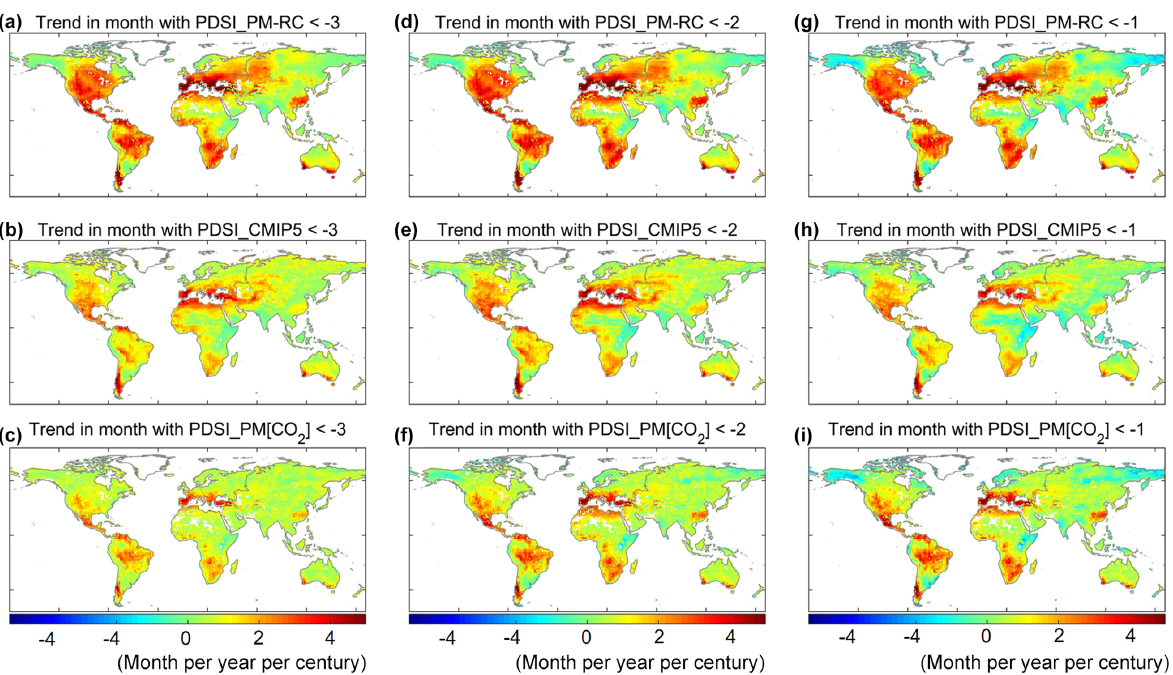
Figure 4. Global spatial pattern of drought trends. (a–c) Spatial distribution of trends in the number of months under severe drought (PDSI < − 3 . 0) during 1901–2100 for (a) PDSI_PM-RC, (b) PDSI_CMIP5, and (c) PDSI_PM[CO 2 ], respectively. (d–f) Spatial distribu- tion of trends in the number of months under moderate drought (PDSI < − 2 . 0) during 1901–2100 for (d) PDSI_PM-RC, (e) PDSI_CMIP5, and (f) PDSI_PM[CO 2 ], respectively. (g–i) Spatial distribution of trends in the number of months under mild drought (PDSI < − 1 . 0) during 1901–2100 for (g) PDSI_PM-RC, (h) PDSI_CMIP5, and (i) PDSI_PM[CO 2 ],